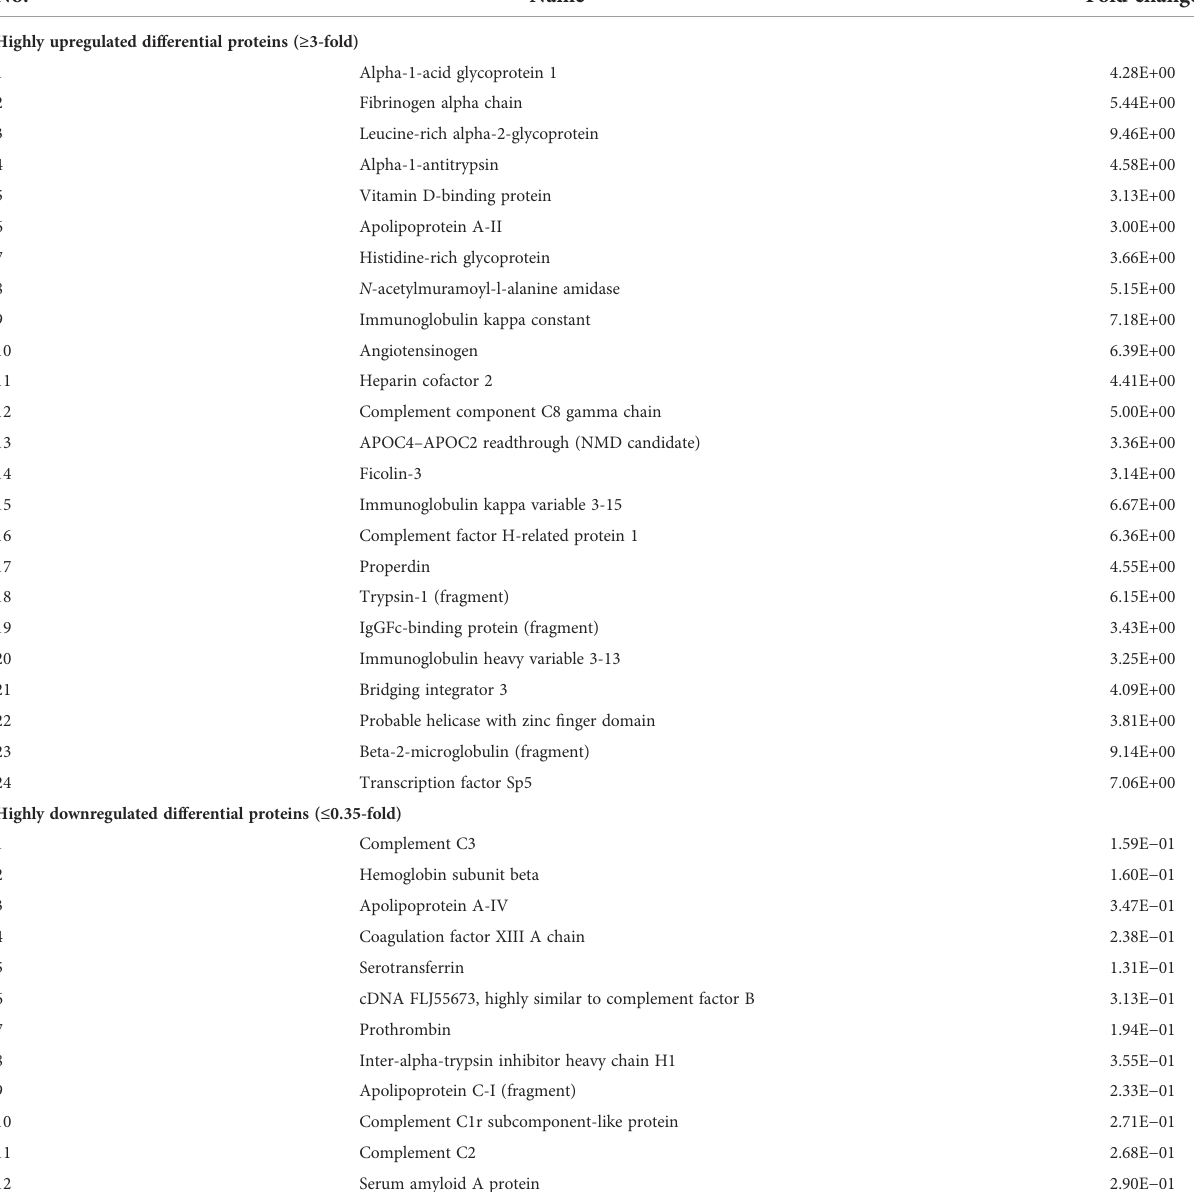
TABLE 1 Highly differentially expressed proteins (upregulated ≥ 3-fold and downregulated ≤ 0.35-fold) identi fi ed using an isobaric tag for relative and absolute quantitation (iTRAQ) and sequential window acquisition of all theoretical mass spectra (SWATH-MS). No. Highly upregulated differential proteins ( ≥